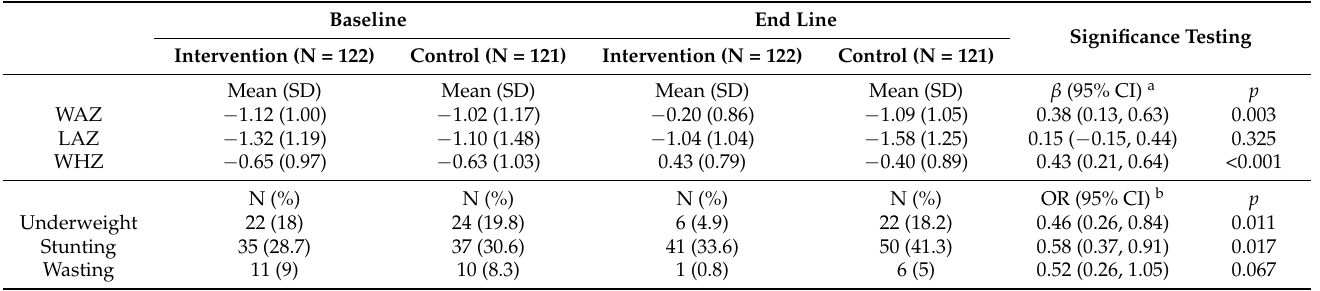
Table 2. Nutritional status of intervention and control groups at baseline and end line.